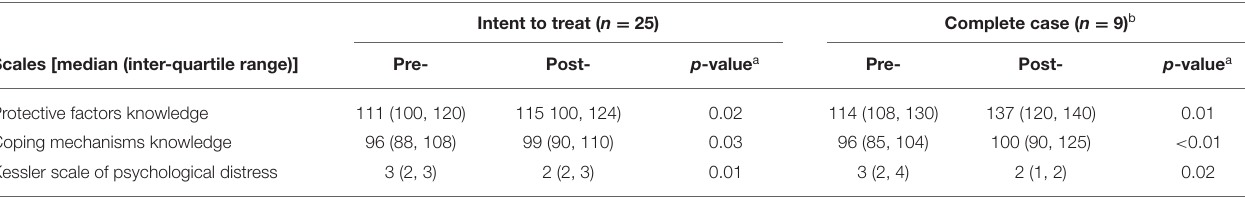
TABLE 2 | Pre- and post-evaluation scores for protective factors and coping mechanisms knowledge, and psychological distress among Mexican immigrants who participated in a mental health promotion intervention ( n = 9). Intent to treat ( n = 25) Complete case ( n = 9) b Scales [median (inter-quartile range)] Pre- Post- p -value